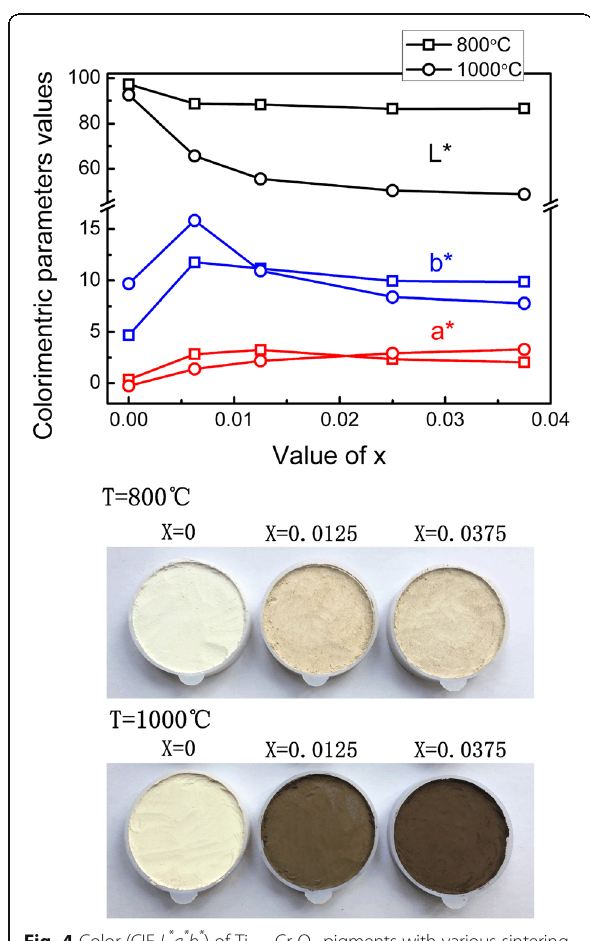
Fig. 4 Color (CIE L * a * b * ) of Ti 1 − x Cr x O 2 pigments with various sintering temperatures and Cr